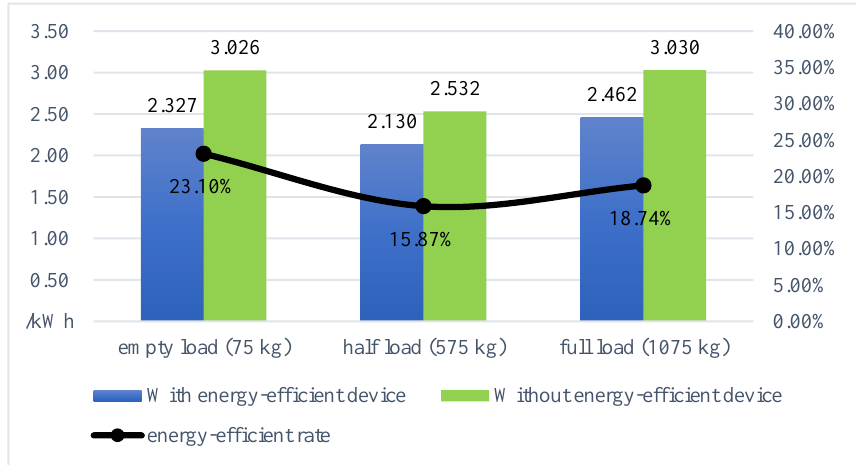
Figure 11. The energy consumption and energy-efficient rate in the experiment.